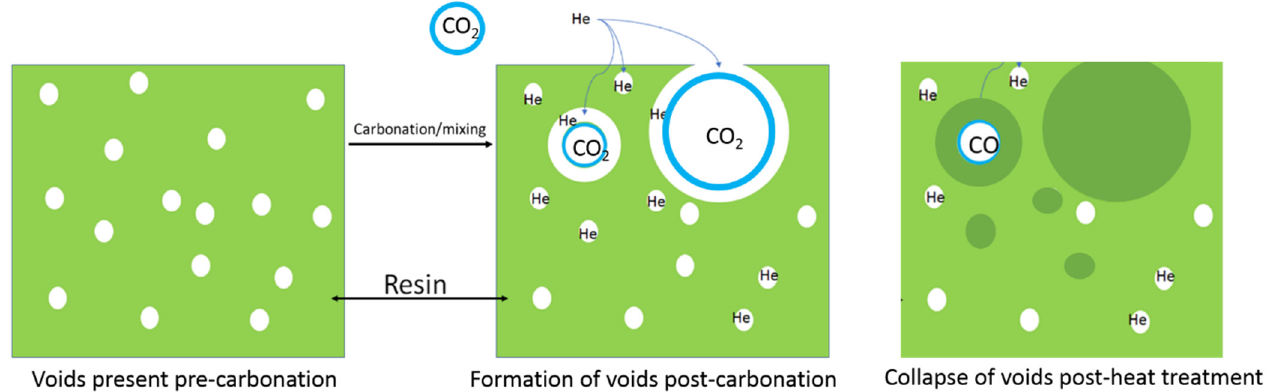
Figure 8. Illustration showing void formation due to carbonation, pycnometer He gas displacement, and void collapse due to post-heat treatment.